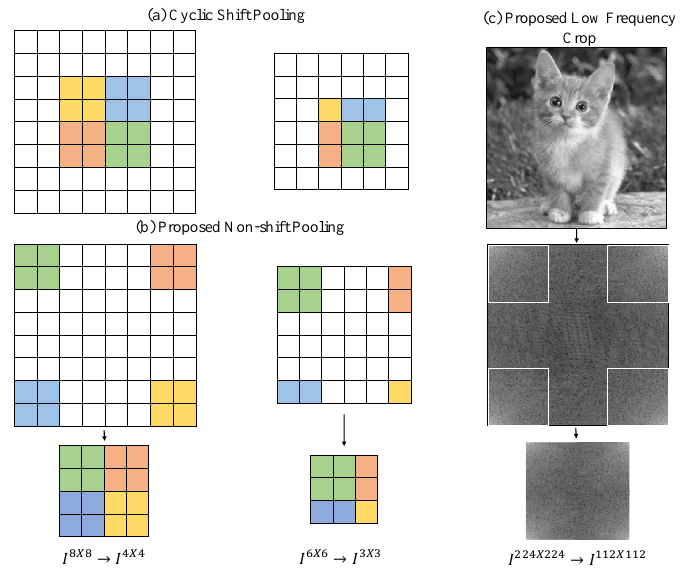
Figure 5. Comparison between standard cyclic shift pooling and our proposed non-shift pooling. ( a ) Cyclic pooling method. ( b ) Non-shift pooling method. The left and right sides of the figure for ( a , b ) describe a kernel divisible by 4 (e.g., size 8 × 8) and a kernel size not divisible by 4 (e.g., size 4 × 4). ( c ) Our proposed non-shift pooling method. The image is one example of a free download that is 224 × 224 in size and down-sampled into 112 ×